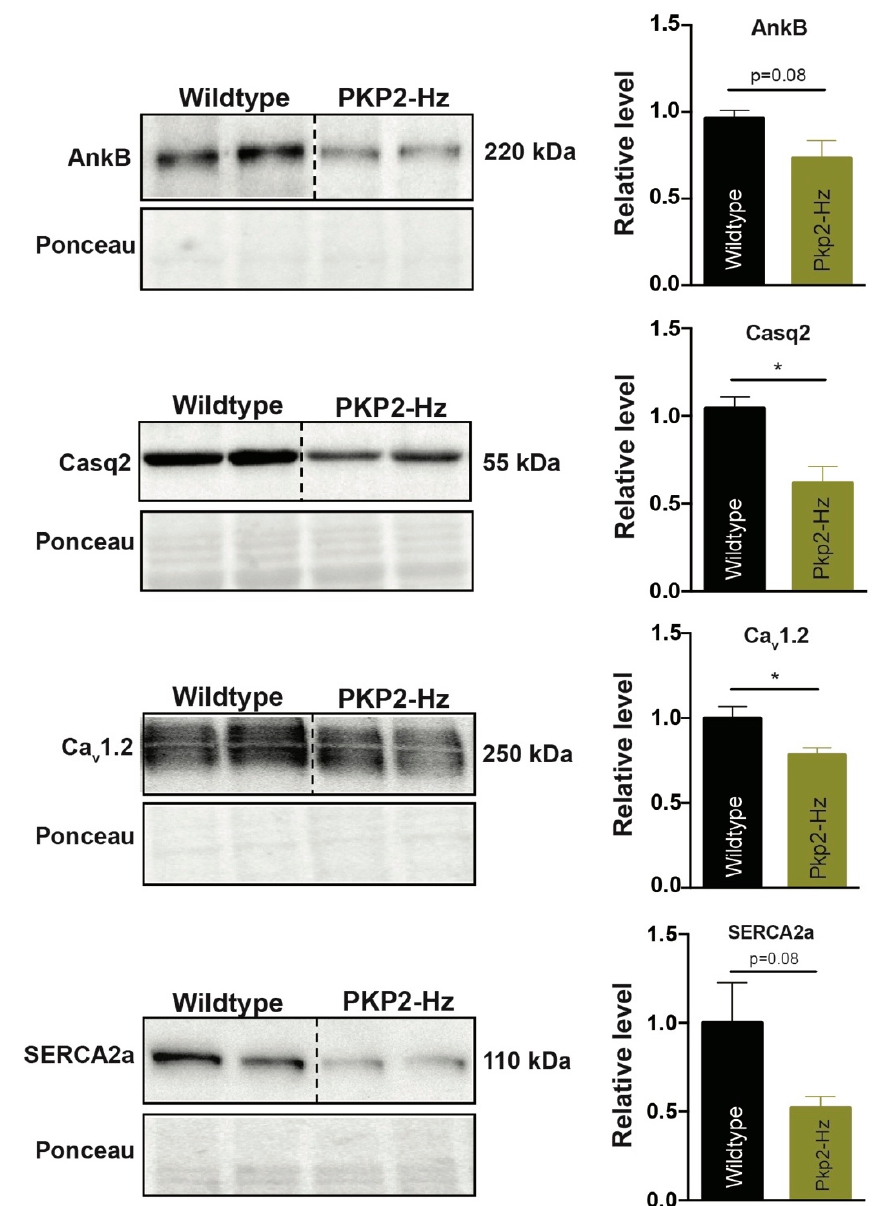
Figure 1. Remodeling of proteins involved in calcium signaling pathways in the PKP2-Hz mouse. Representative western blots (left) and average densitometry (right; n = 5 for all groups) of ankyrinB (AnkB), calsequestrin-2 (Casq2), Ca v 1.2, and SERCA2a, measured from wildtype and PKP2-Hz ventricular lysates of three-month-old mice. Left upper panels represent western blots, bottom panels according to ponceau staining used for quantification (mean ± SEM, * p <